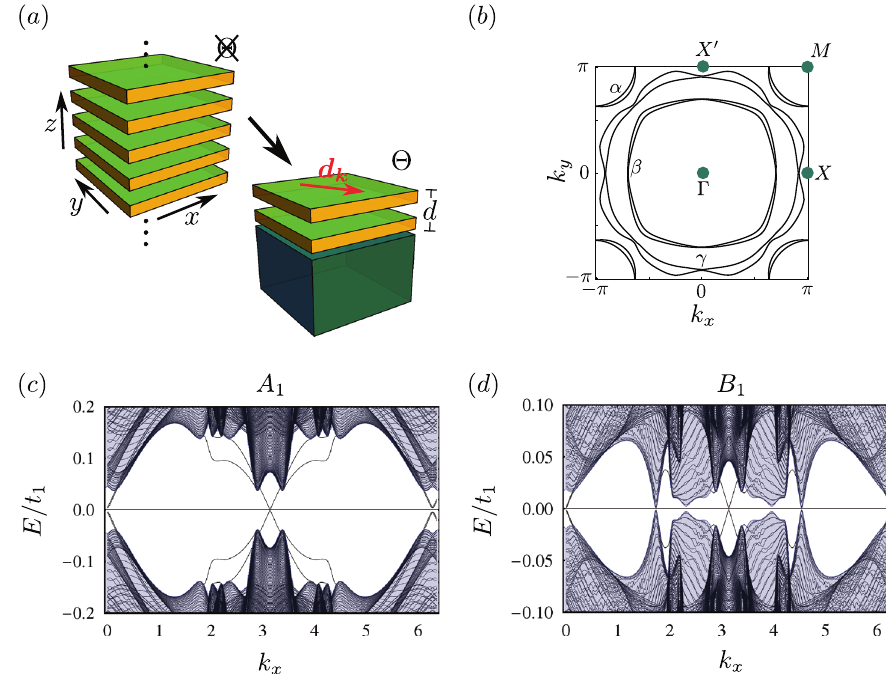
Fig. 2 a Illustration of the gedankenexperiment explained in the main text with superconductor and substrate shown in yellow and green , respectively. b Fermi surfaces of thin layers of Sr 2 RuO 4 following from the model de fi ned in the “ Methods ” section. c and d show the low- energy part of the spectrum of the superconducting states transforming under A 1 and B 1 for open (periodic) boundary conditions along the y ( x ) direction. For concreteness, we have taken pure triplet pairing with d / 0 : 2 t 1 ð sin k y ; (cid:2) sin k x ; 0 Þ T and d / 0 : 08 t 1 ð sin k y ; sin k x ; 0 Þ T , respectively (cf. Table 1). As argued in the main text, the spectra of the B 2 and A 2 pairing states look qualitatively similar to ( c ) and ( d